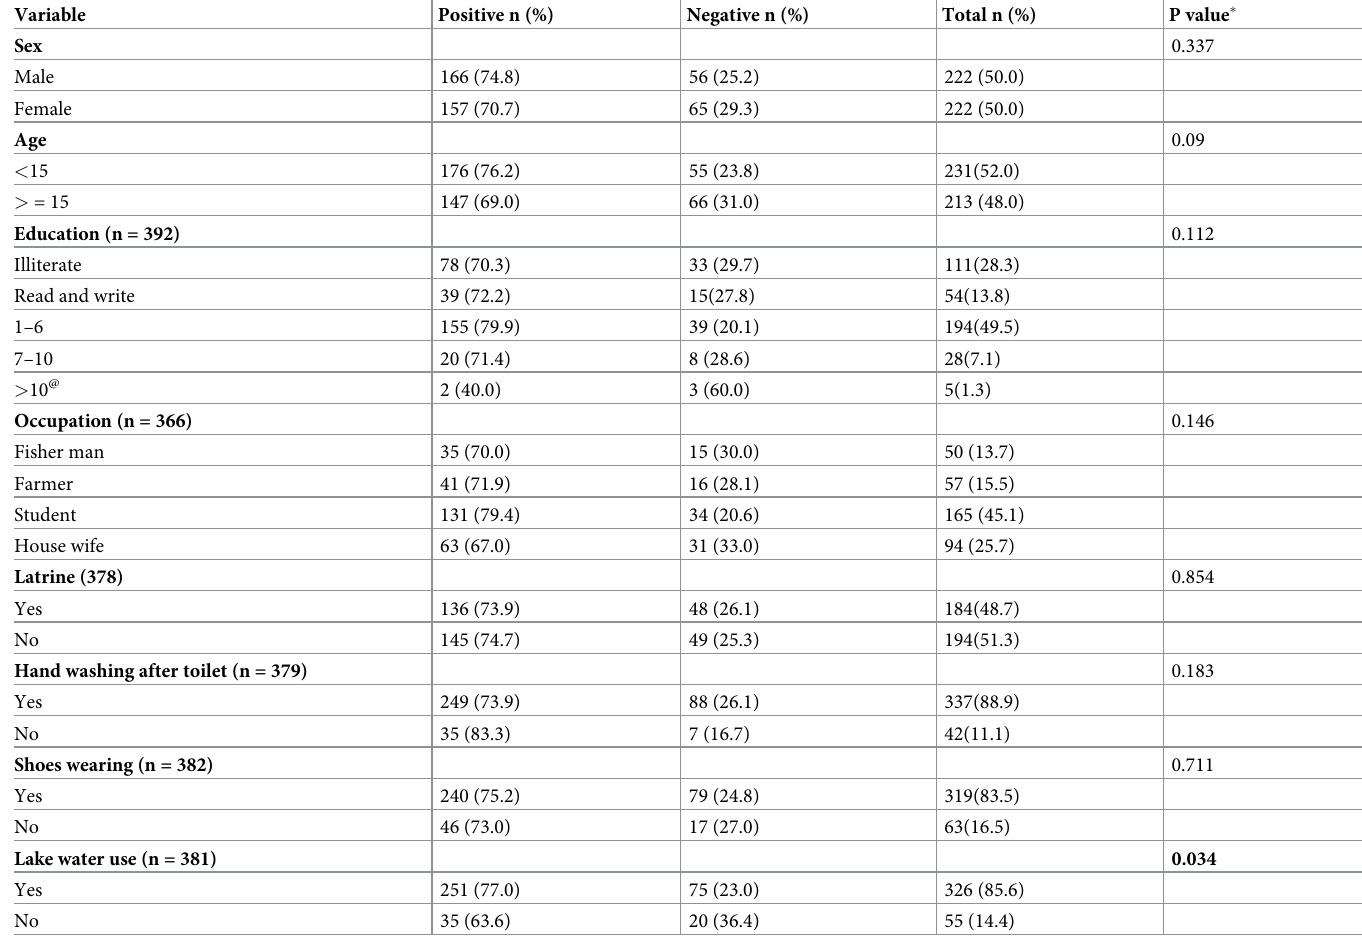
Table 1. Socio-demographic characteristics of study participants from three islands around Lake Ziway, Oromia Region, Ethiopia,